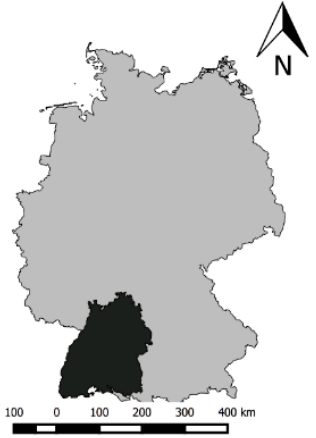
Figure 2. Study area Baden-Württemberg (black) located in southwest Germany (grey).